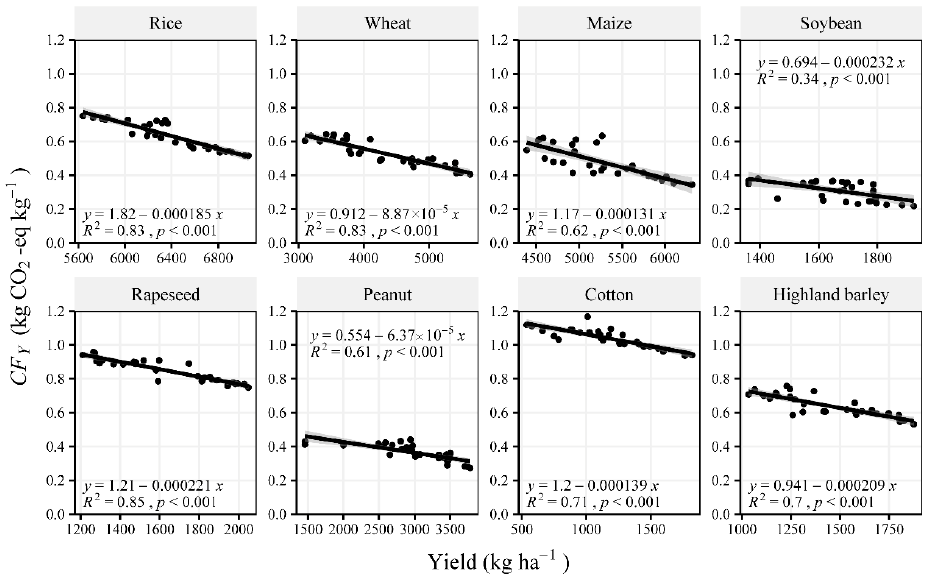
Figure 7. Correlations between the carbon footprint per unit yield ( CF Y ) and crop yield for the study period.